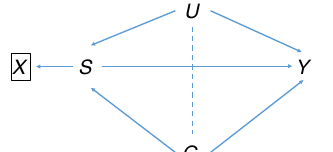
Fig. 4 Association of SNP G with prognosis Y conditional on incidence X derived from trait S . U is a composite variable as in Fig. 1. For example, X may be a diagnosis of disease (e.g., Crohn ’ s disease), and S a subtype of disease (e.g., ileal, colonic, ileocolonic or healthy). Conditioning on X , which is a descendant of the collider S , induces the moralised association between G and U shown by the dotted line. This creates association of G with Y via the path G (cid:2) U ! Y in addition to its direct effect via G ! Y and its mediated effect via G ! S ! Y . Further conditioning on S blocks